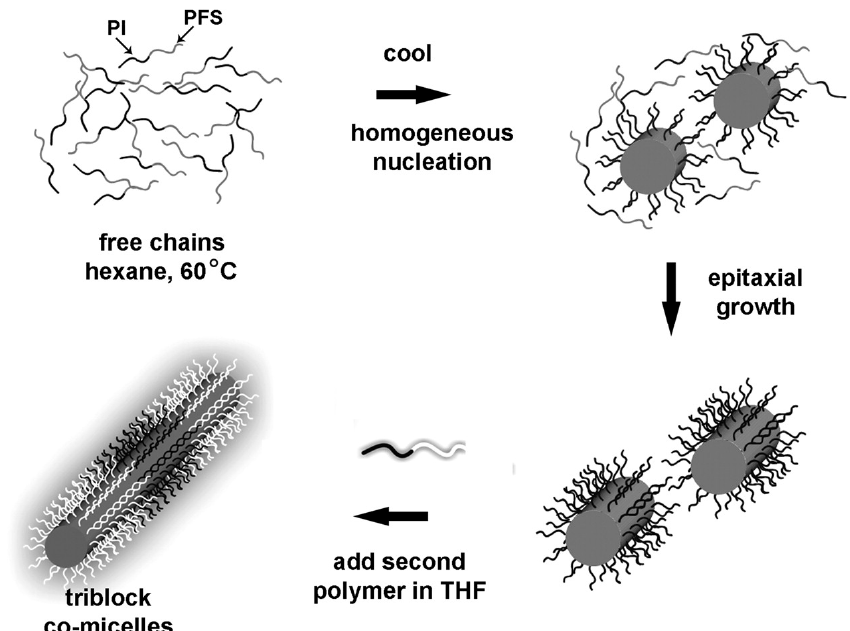
Figure 12. The schematic representation of the micelles from polyferrocenylsilane (PFS)—containing BCPs via epitaxial growth. Reprinted from Reference [82]. (Copyright (2007) American Association for the Advancement of Science).